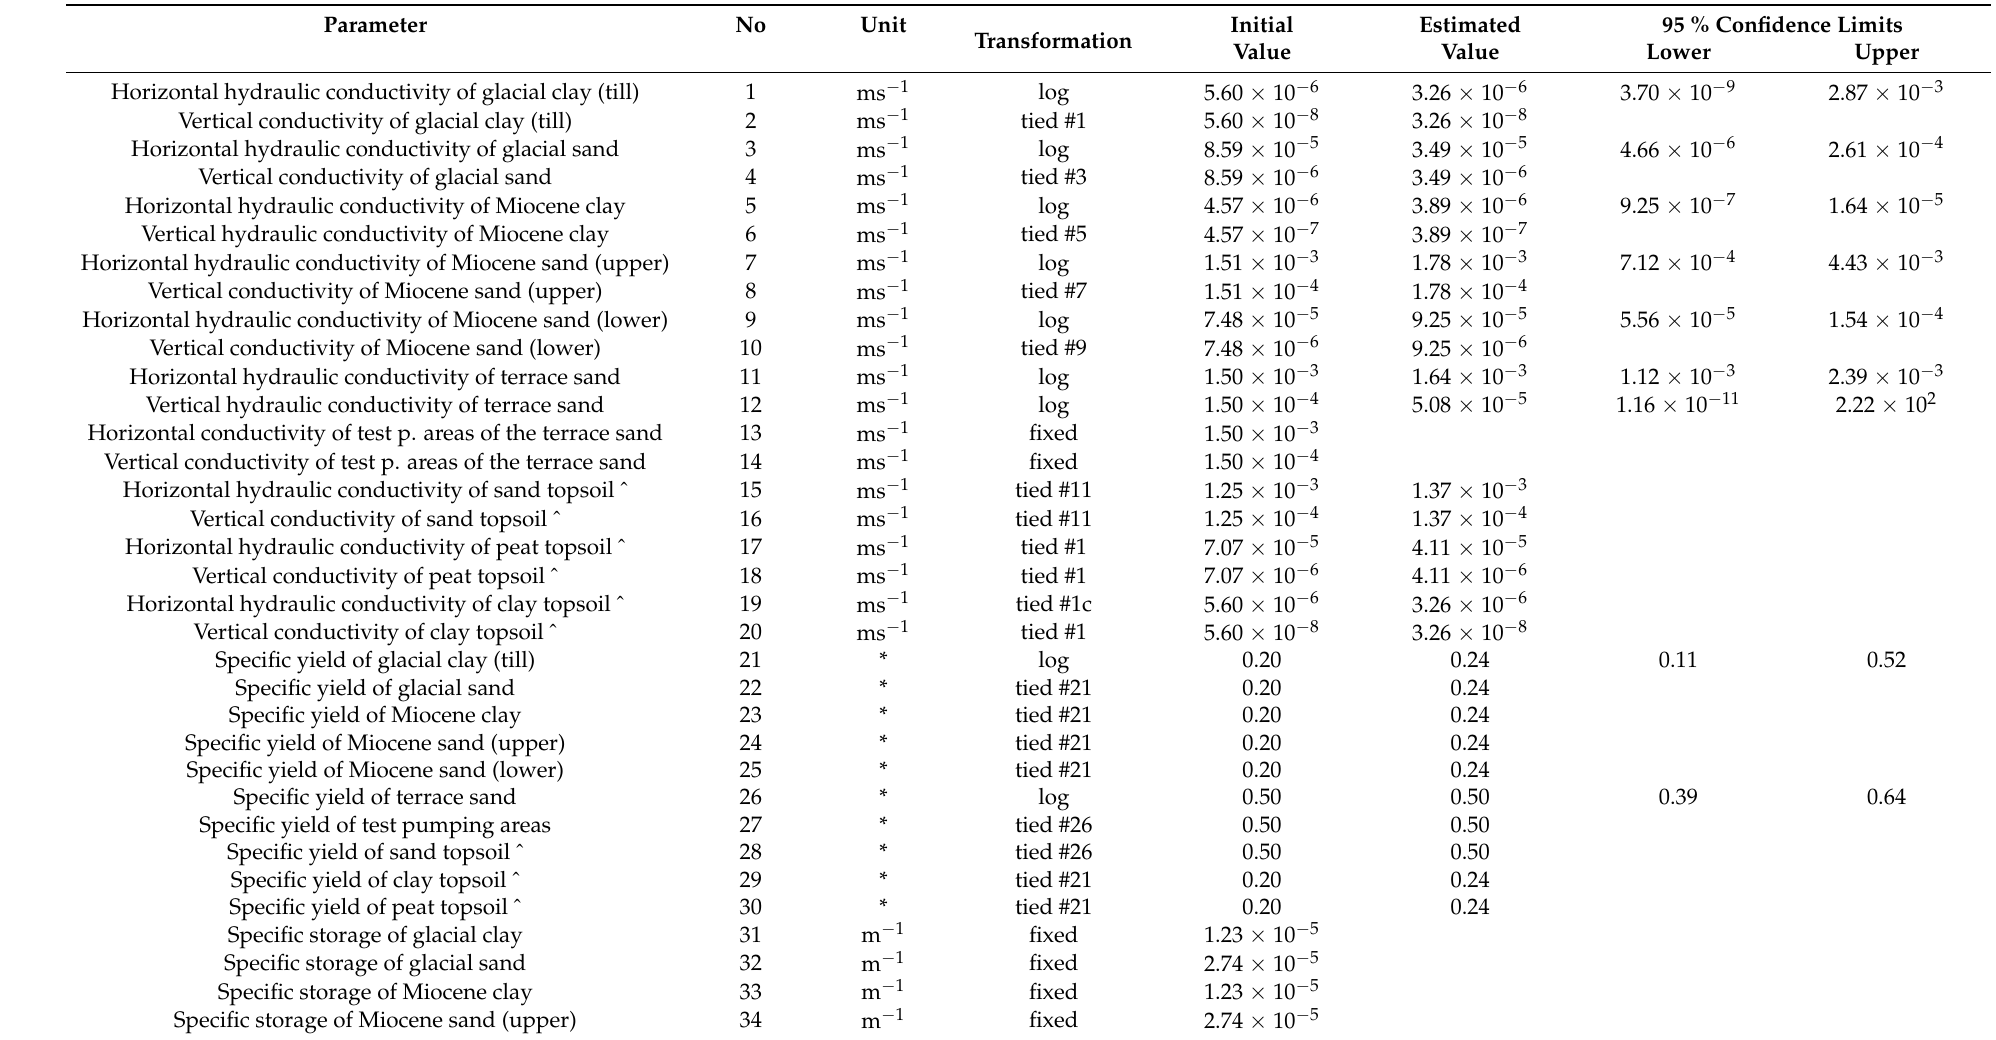
Table A3. Calibration of Post audit-Hydrogeology